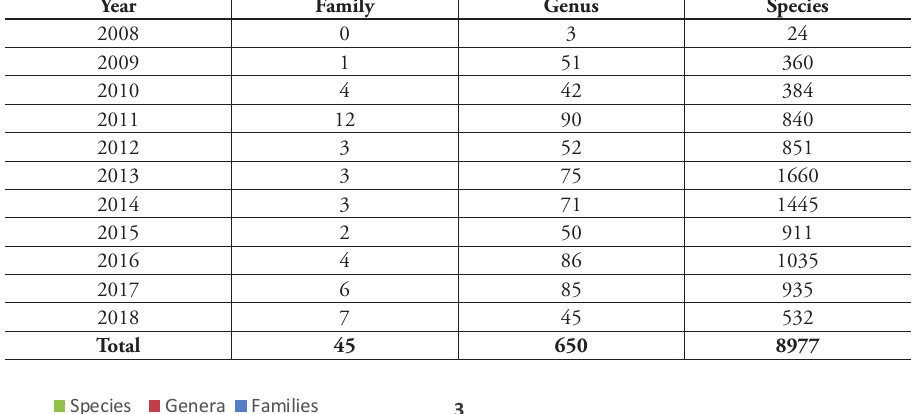
Table 2. New taxa published in ZooKeys, registered in ZooBank (courtesy of Richard Pyle). Year Family